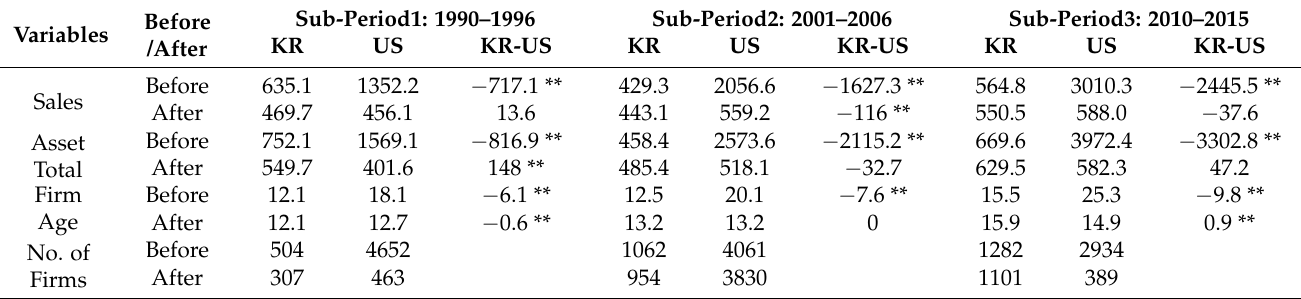
Table A1. Firm size and age before and after propensity score matching.